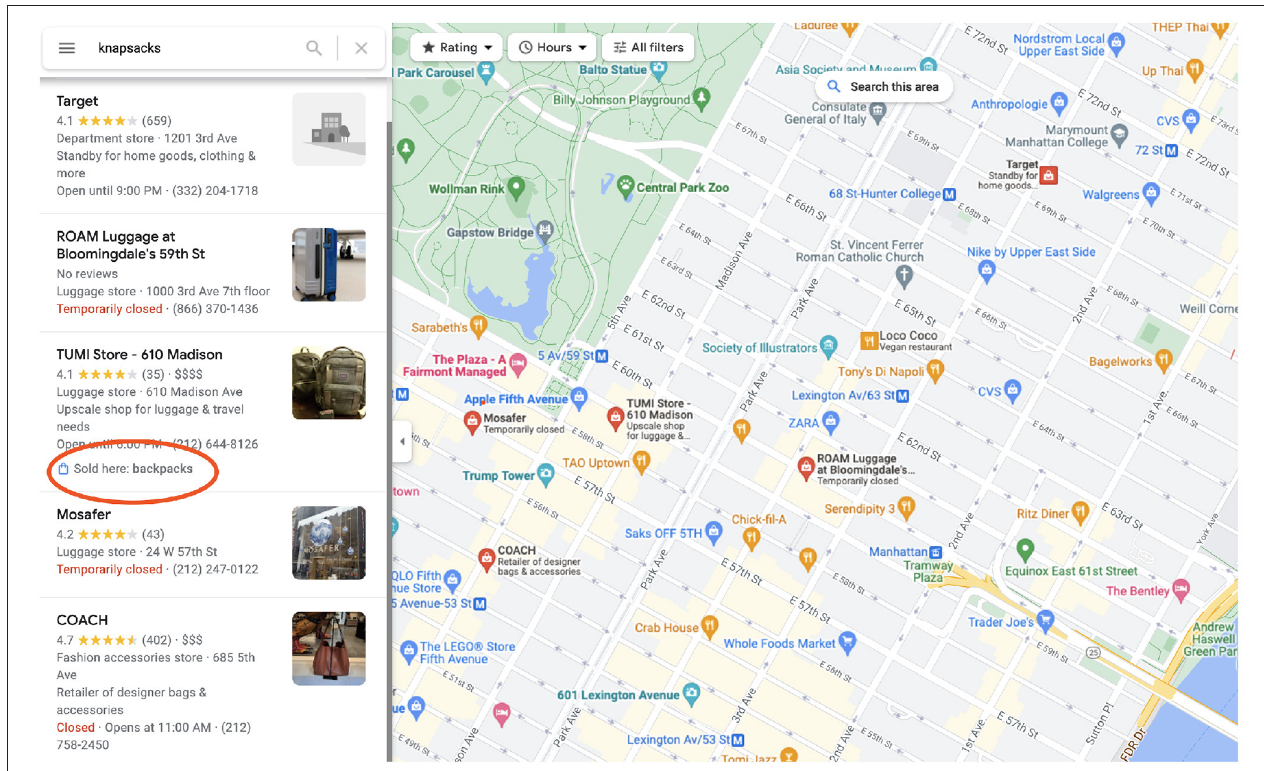
FIGURE 9 | CrowdSense search results in NYC for